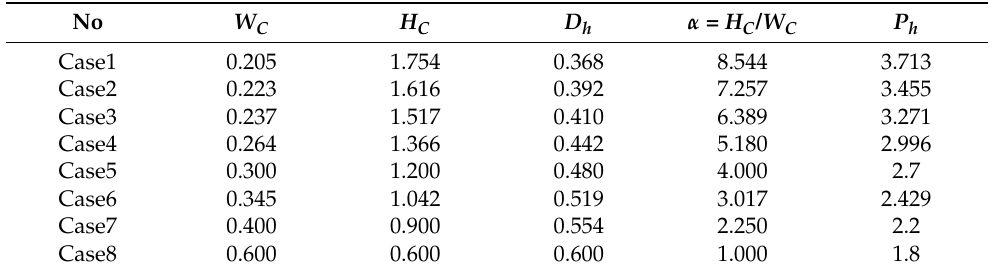
Table 3. Parameters of eight different kinds of rectangular microchannels ( A C = 0.36 mm 2 unit: mm).